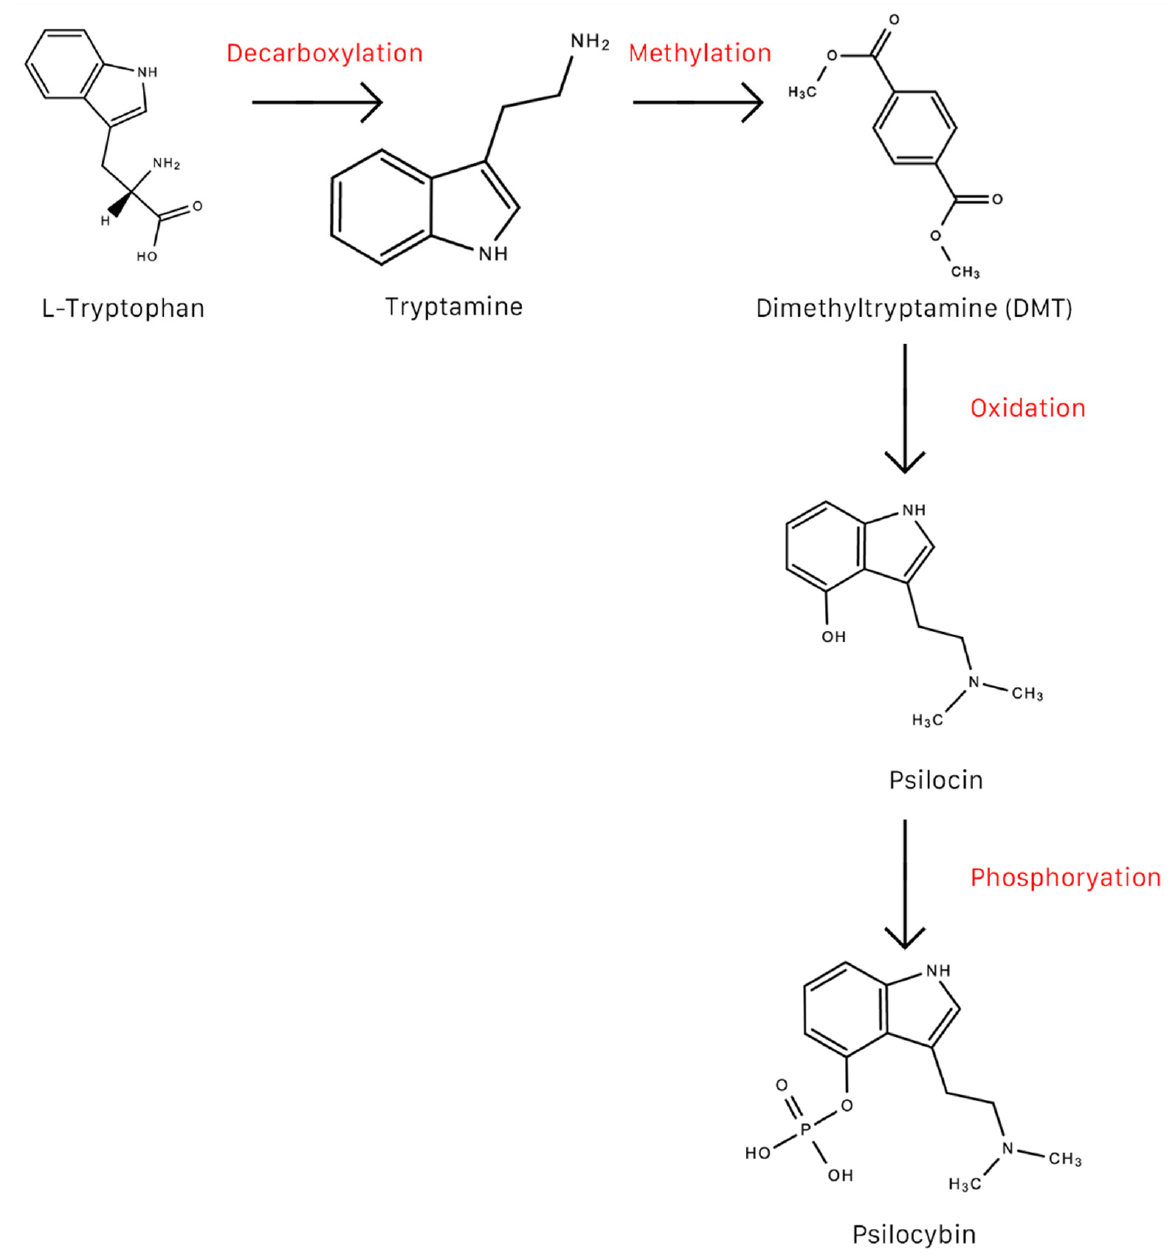
Figure 4. Conversion of L-tryptophan to psilocybin.